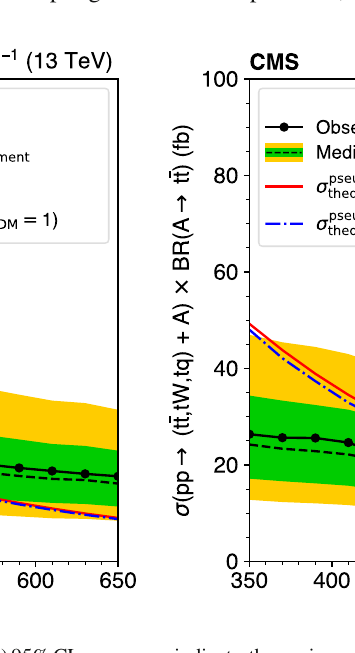
indicate the regions containing 68 and 95%, respectively, of the dis- tribution of limits under the background-only hypothesis. Theoretical values are shown for Type-II 2HDM in the alignment limit (solid line) and simplified dark matter (dot-dashed line)